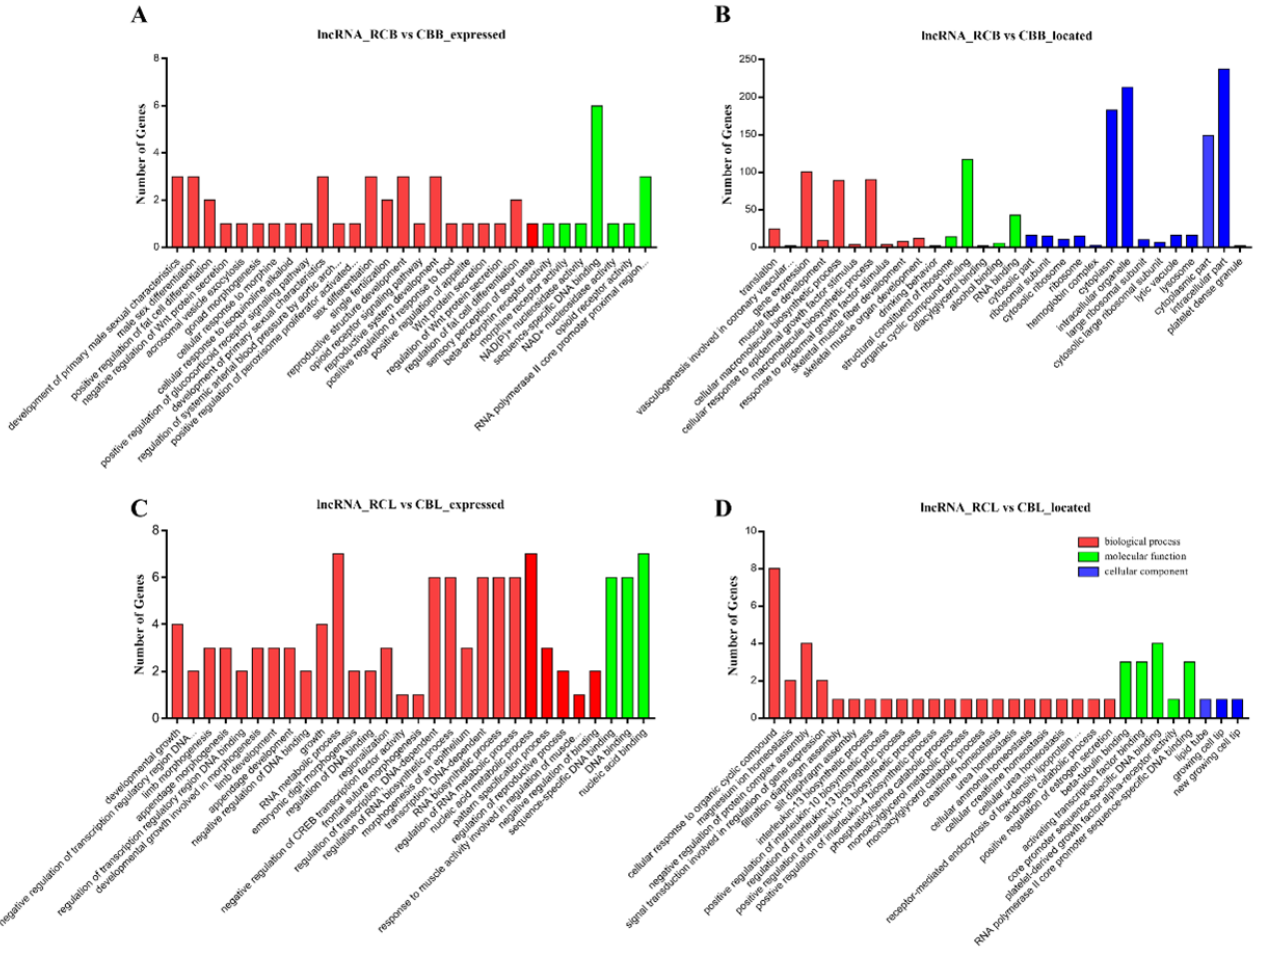
Figure 5. GO analysis of differentially expressed lncRNAs. (A) GO analysis of cis target genes in RCB vs CBB. (B) GO analysis of trans target genes in RCB vs CBB. (C) GO analysis of cis target genes in RCL vs CBL. (D) GO analysis of trans target genes in RCL vs CBL. Red denotes biological processes, green denotes molecular functions, blue denotes cellular components; the top 30 terms identified in the analysis are displayed. GO, gene ontology; RCB, rose-crown chicken breast muscles; CBB, Cobb broiler chicken breast muscles; RCL, rose-crown chicken leg muscles; CBL, Cobb broiler chicken leg